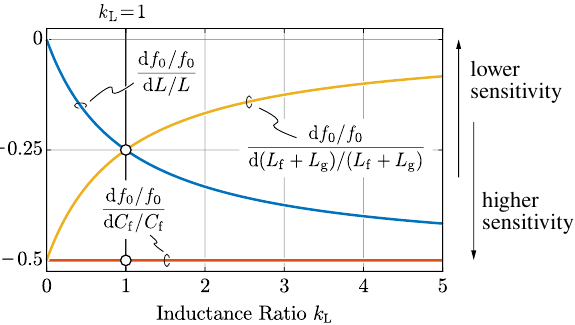
Figure 6. Per unit sensitivities of the LCL filter resonance frequency f 0 with respect to the per unit filter parameter variations, as functions of the inductance ratio k L